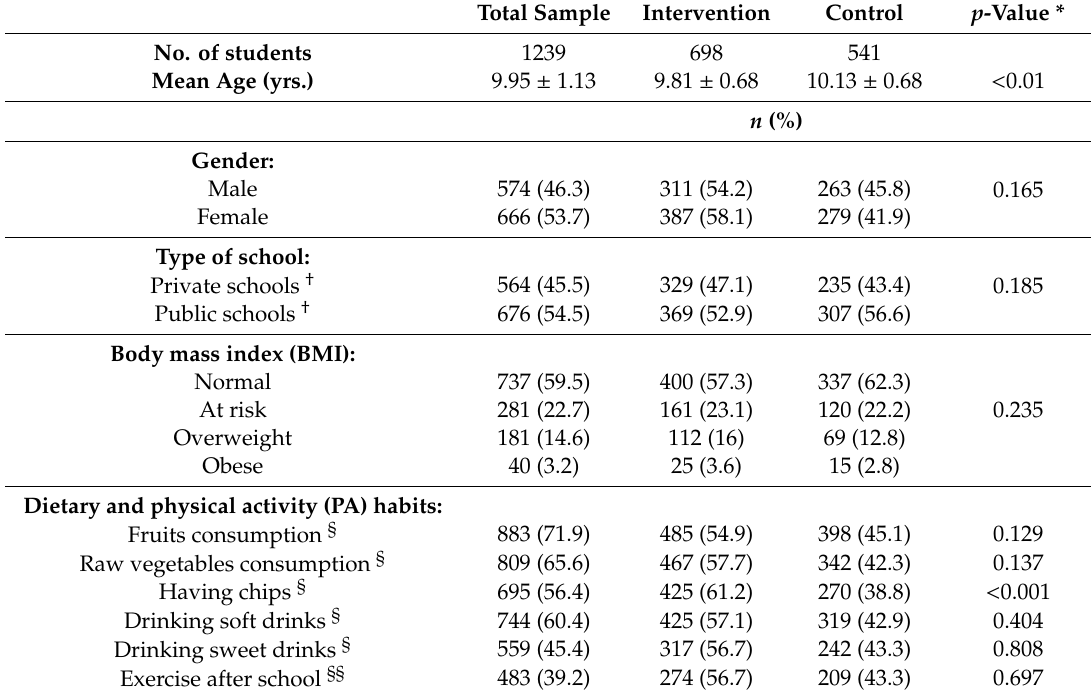
Table 1. Baseline characteristics of participating students in intervention and control